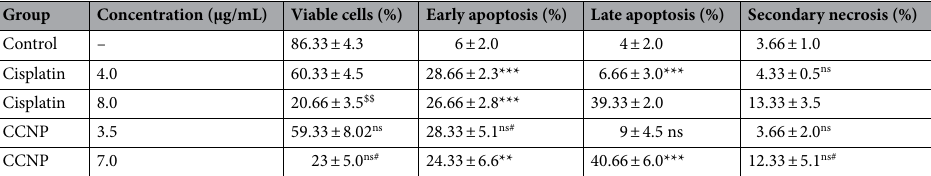
Table 3. Apoptosis study on nanoparticle treatment. Each value is the mean of 3 batches (n = 3) with a standard deviation by performing one-way ANOVA followed by Tukey’s test (post hoc test). ns Non-significant when compared to control sample at p > 0.05; ns# Non-significant when compared to cisplatin concentration of 8.0 µg/mL at p > 0.05; $$ Significant when compared to when compared to cisplatin concentration of 4.0 µg/mL and control sample at p < 0.001; **Significant when compared to control sample at p < 0.01; ***Significant when compared to control sample at p < 0.001; CCNP: Cisplatin loaded chitosan